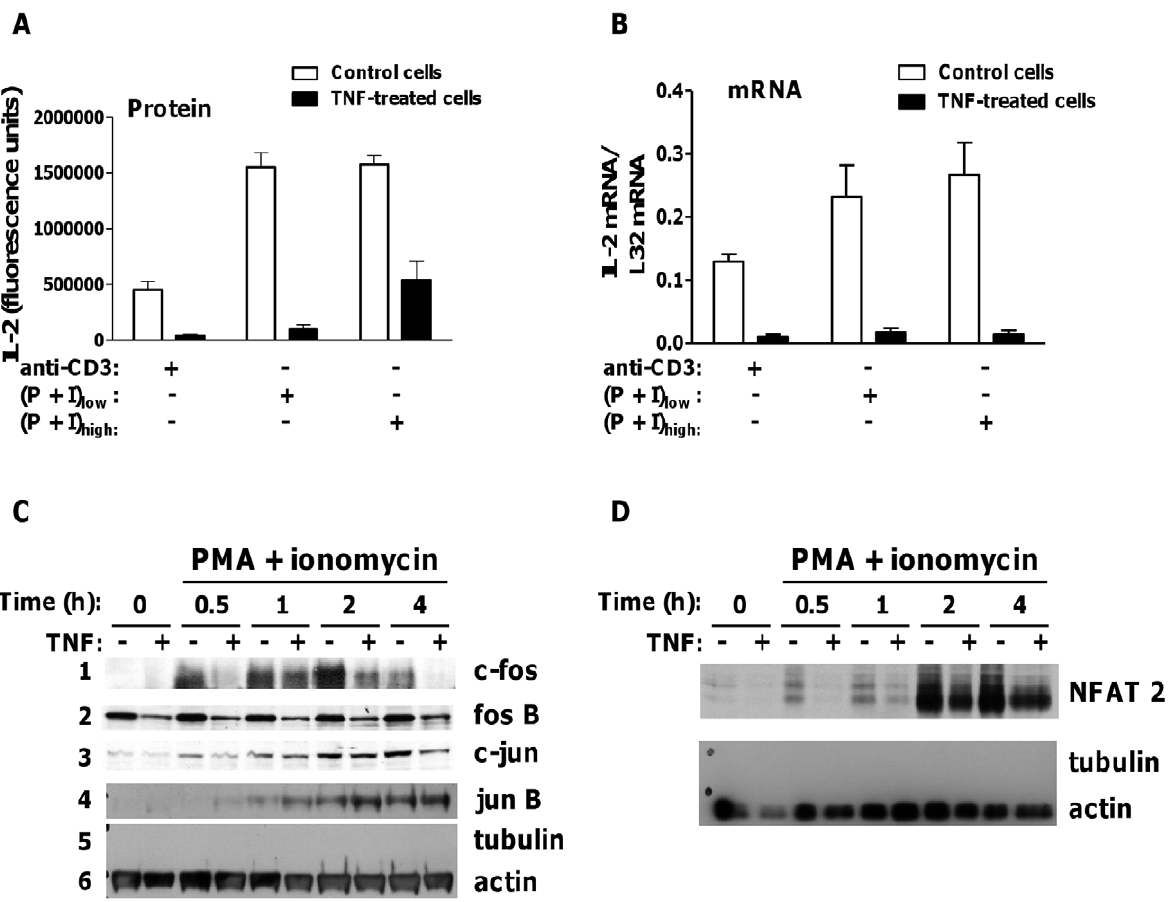
Figure 1. TNF inhibits IL-2 gene transcription and attenuates induction of AP-1 and NFAT. 11A2 cells were cultured with or without TNF 2.5 ng/ml for 8 days before (A) restimulation with plate-bound anti-CD3 e 5 m g/ml, PMA 10 ng/ml and ionomycin 50 ng/ml (P + I) low , or PMA 50 ng/ml and ionomycin 100 ng/ml (P + I) high for 24 hours. Secreted IL-2 protein was measured by immunoassay (mean + / 2 SEM, n=5 experiments); (B) restimulation as above for 4 hours followed by RNA extraction, and analysis for IL-2 mRNA by RNase protection assay (mean + / 2 SD, n=3 experiments). After restimulation with (P + I) low , nuclear and cytoplasmic extracts were prepared, and equivalent amounts of protein assayed by immunoblot for (C) nuclear AP-1 and (D) nuclear NFAT2 (representative of 3 experiments for each condition). Each blot was probed then reprobed for the indicated proteins.